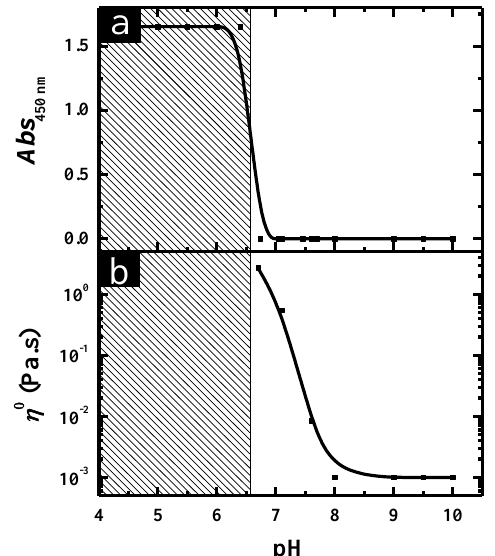
Figure 1. ( a ) Turbidity and ( b ) zero-shear viscosity η o of C 12 C 3 C 12 (SO 3 ) 2 solutions plotted against pH at C T = 20.0 mM.